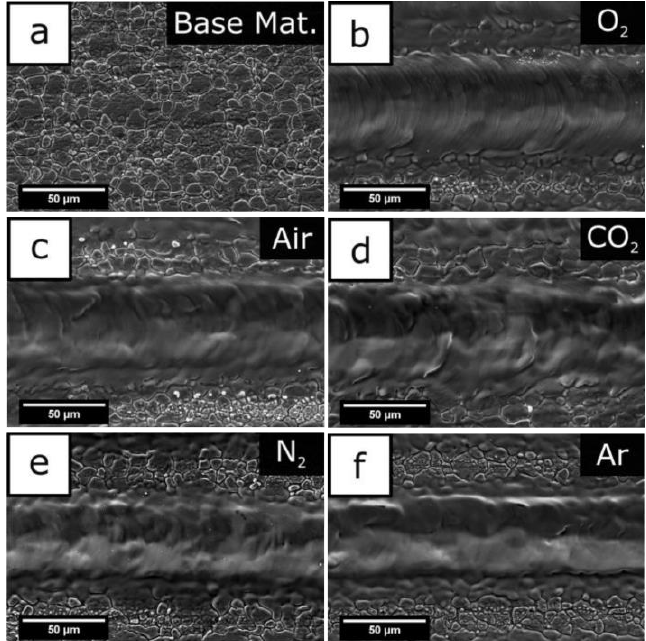
Figure 19. ( a ) Foundation base, ( b ) oxygen atmosphere processing, ( c ) air atmosphere processing, ( d ) carbon dioxide atmosphere processing, ( e ) nitrogen atmosphere processing, and ( f ) argon atmosphere processing (Reprinted with permission from Ref. [79]. 2019, Pou, P.).